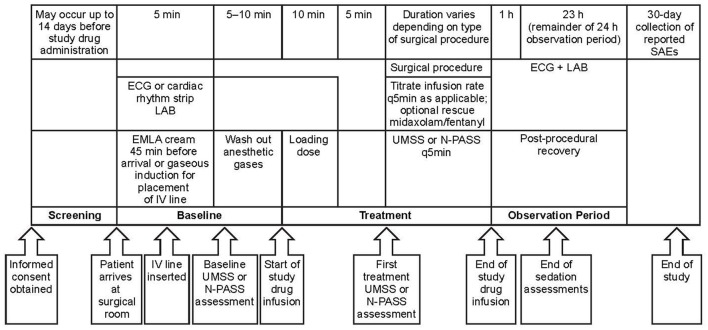
Study design. One patient enrolled in dose level 2 did not receive study medication due to administrative reasons. EMLA, eutectic mixture of local anesthetics; ECG, electrocardiogram; IV, intravenous; LAB, laboratory assessment; N-PASS, Neonatal Pain, Agitation and Sedation Scale; q5 min, every 5 min; SAE, serious adverse event; UMSS, University of Michigan Sedation Scale.